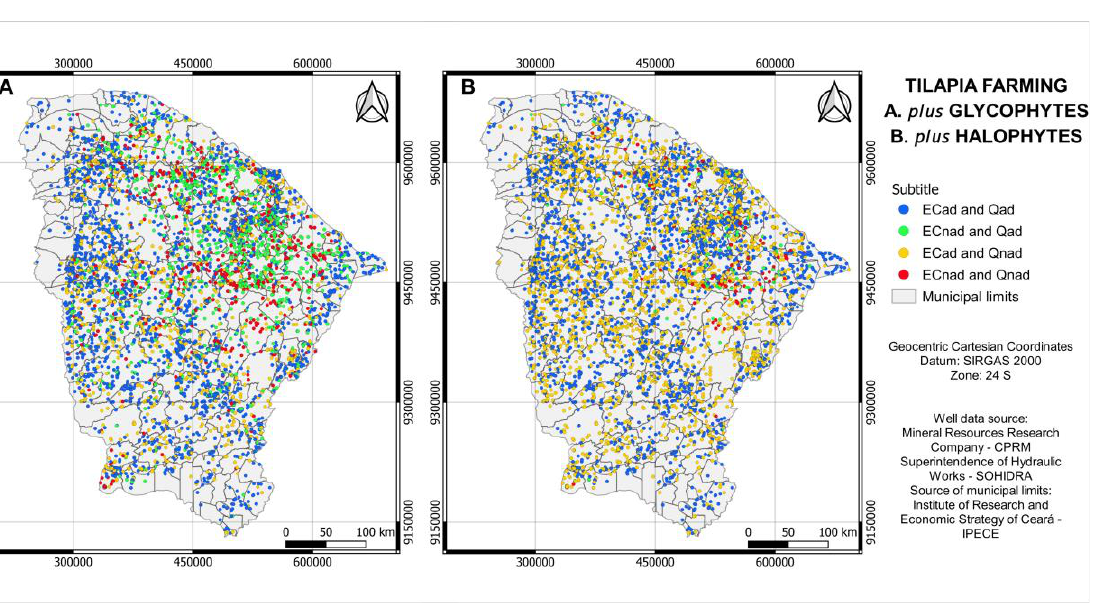
Figure 8. Potential of brackish groundwater in the State of Ceará (Northeast Brazil) for associations of fish (tilapia) plus glycophytes ( A ) and fish (tilapia) plus halophytes ( B ), based on the threshold electrical conductivity of the irrigation water (EC) and discharge rate (Q). EC ad : adequate electrical conductivity; EC nad : inadequate electrical conductivity; Q ad : adequate discharge; Q nad : inadequate discharge.